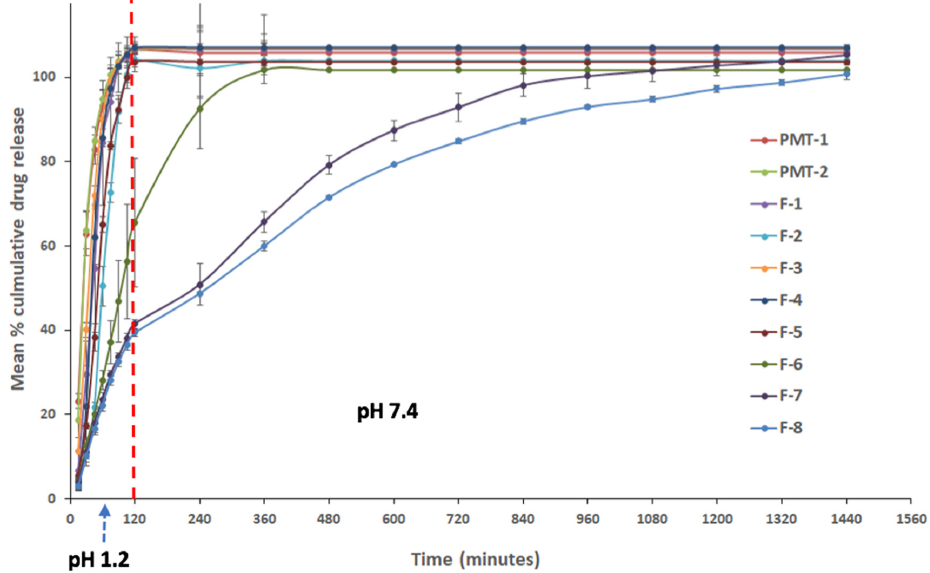
Figure 3. Dissolution profiles of all formulations at pH 1.2 for the first 2 h, then pH 7.4 up to 24 h.